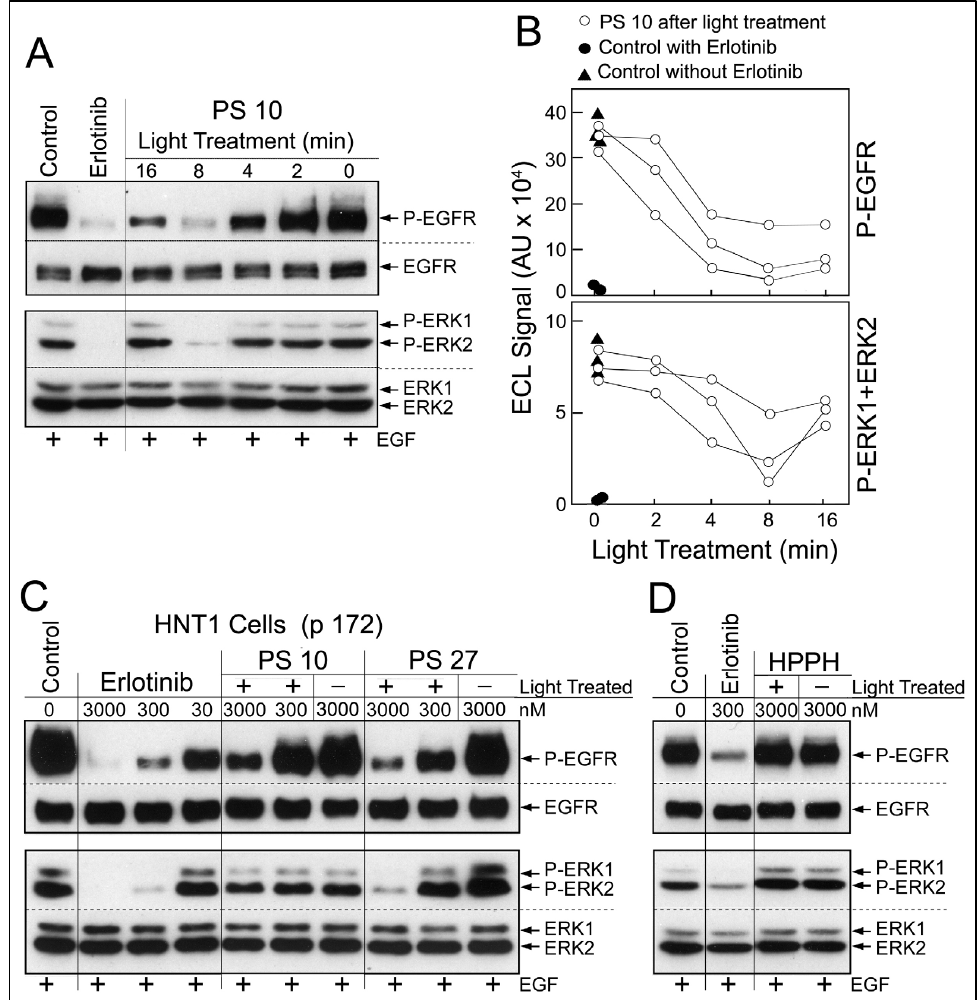
Figure 6. Recovery of EGFR-inhibitory activity following light treatment of PS. ( A ), Solution of PS 10 (3 μM in methanol) was treated with 660 nm light for 16 min (0–5.3 J/cm 2 ). Samples collected over the course of the light treatment were dried. Residues were dissolved in DMSO and diluted (1:1000) in DMEM containing 10% FBS yielding a concentration equivalent of 3 μM original PS 10. These medium samples were subjected to a 30 min EGFR kinase inhibition assay using HNT1 cells (p 170). The activation of EGFR signaling by 15 min treatment with EGF was identified by immunoblotting. ( B ), Three separate sets of light treatment of PS 10 were analyzed for the recovery of EGFR kinase- inhibitory activity by quantifying the immunoblot signals for phosphorylated products. ( C ), Ten-fold diluted samples of 8 min light-treated (2.65 J/cm 2 ) PS 10 and PS 27 were used to measure inhibition of EGFR kinase activity in HNT1 cells (p 172). ( D ), As control, HPPH was subjected to 8 min light treatment (2.65 J/cm 2 ) and products tested for effects on EGFR kinase activity in HNT1 cells (p 173). Note: images of separate immunoblots have been integrated into the shown composite